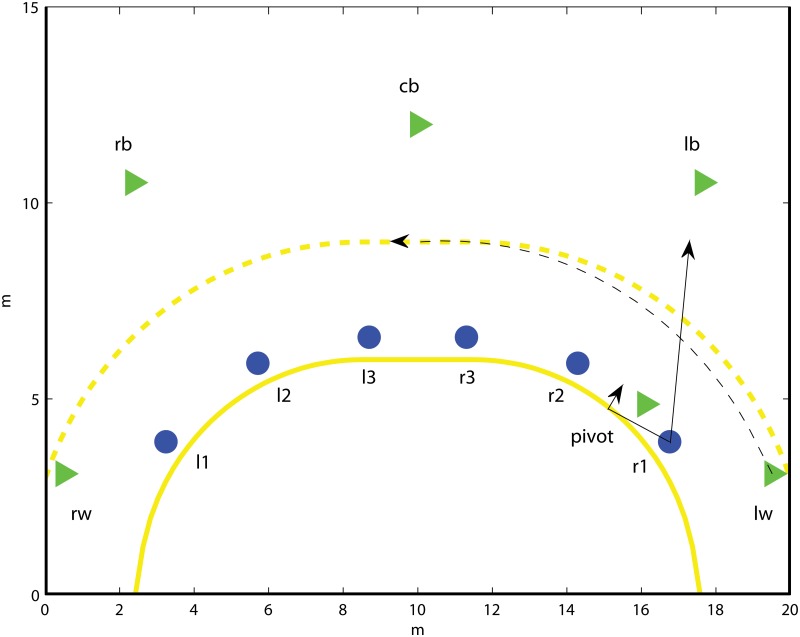
Schematic figure of a wing changeover opening in team handball.The offensive players are denoted by triangles and the defensive players are marked by cirles. The dashed line displays the movement path of lw and the solid lines refer to the possible moves for r1.